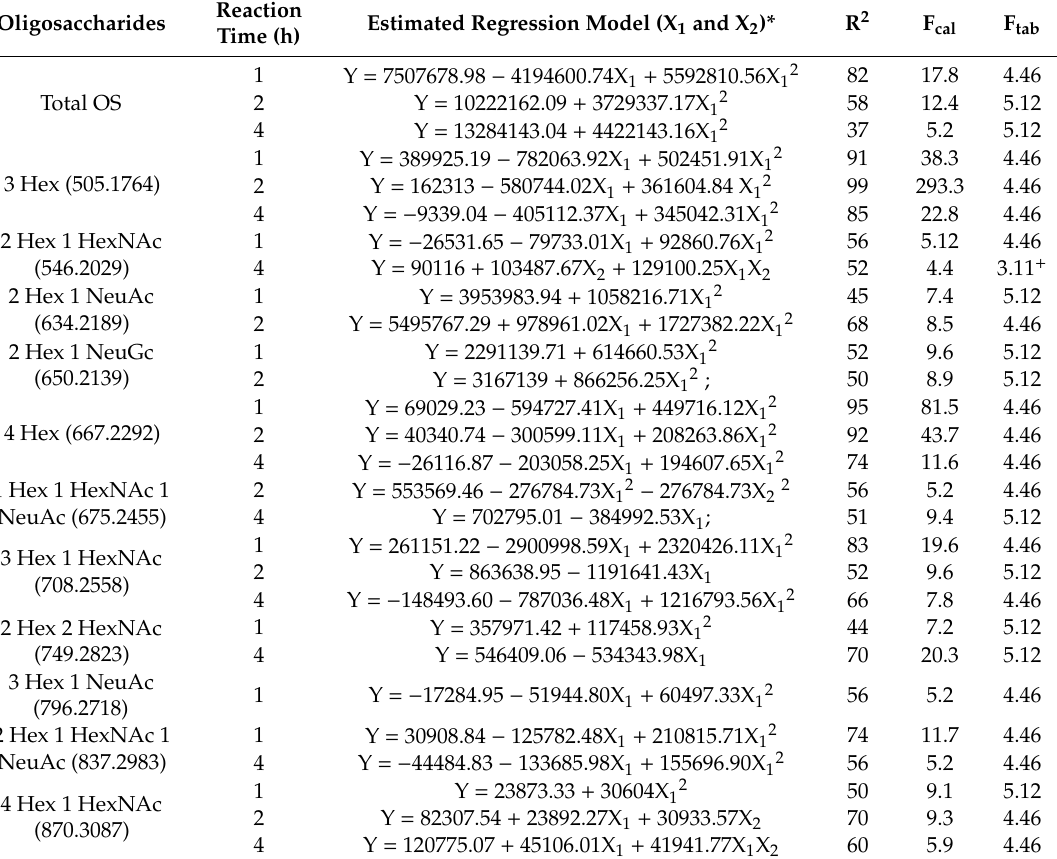
Table 4. Regression models, coe ffi cient of determination (R 2 ) of the estimated regression models for the variation in the relative abundances of total and individual oligosaccharides.